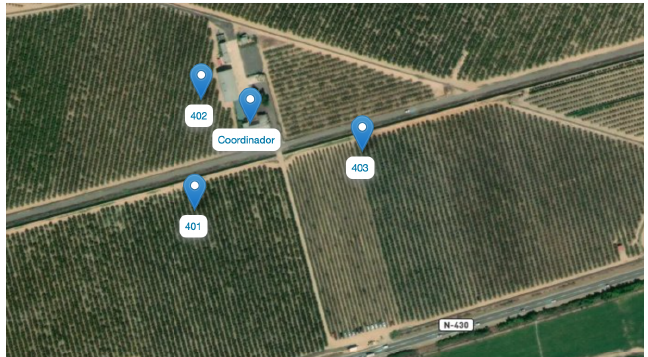
Figure 9. Diagram of the network deployed in Farm 4.